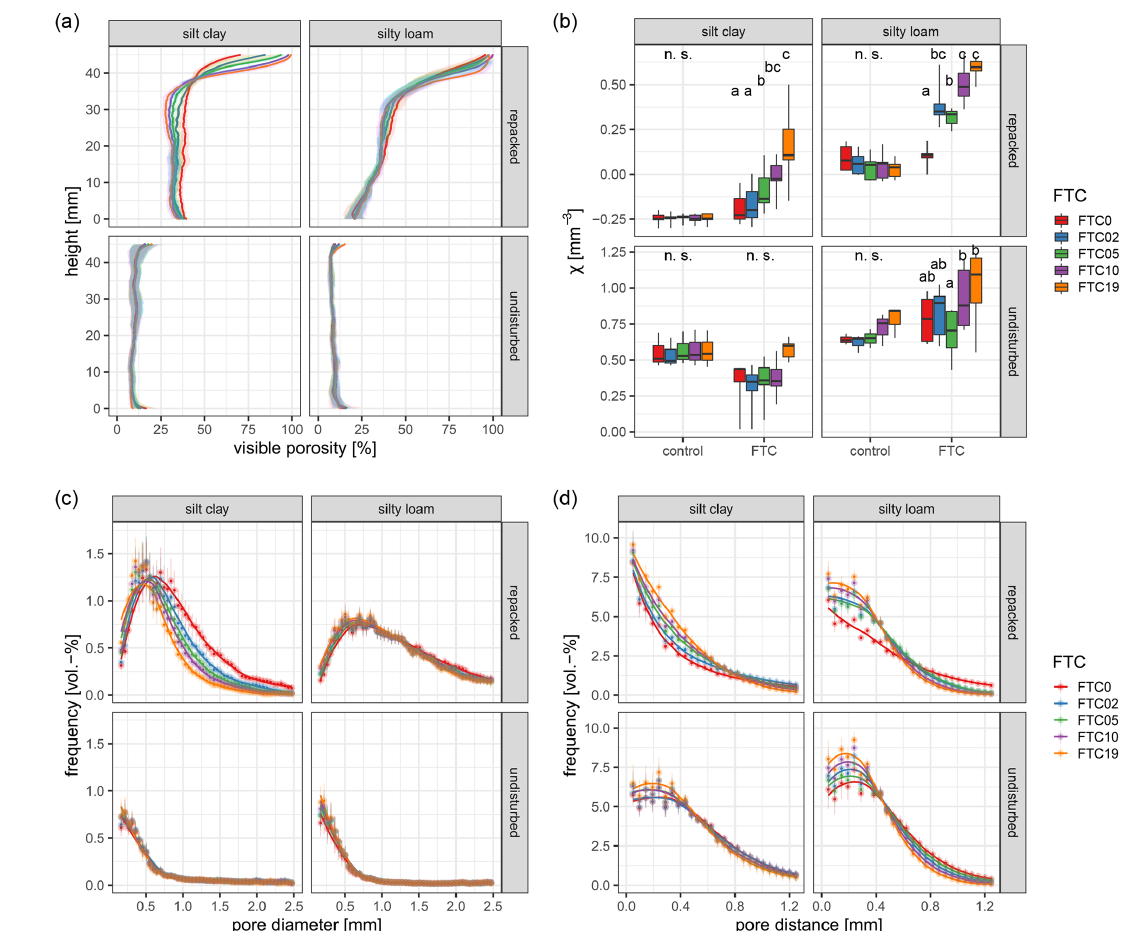
Figure 3. Soil structure characteristics determined at a resolution of 48µm as after multiple freeze–thaw cycles (FTCs), showing the mean visible porosity profile over the sample height (a) , the Euler number density χ (b) , the mean pore size distribution and their fits (c) , and the mean pore distance distribution and their fits (d) . The shaded area in (a) and the point ranges in (c) and (d) mark the 95% confidence interval of the represented data (2 standard errors), with the latter in (b) depicting significant differences at p < 0.05 within a treatment (n.s. – not significant). Note that the y axis in (b) differs for repacked and undisturbed